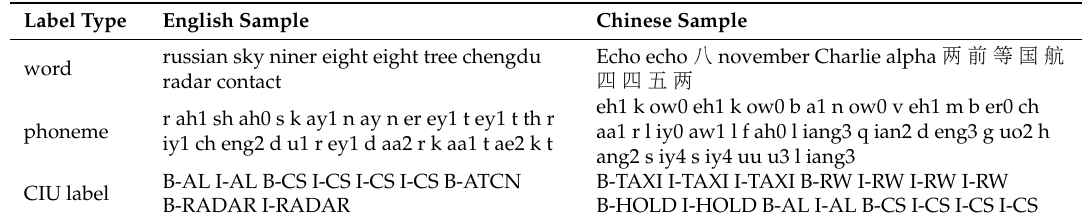
Table 2. Example of training label.